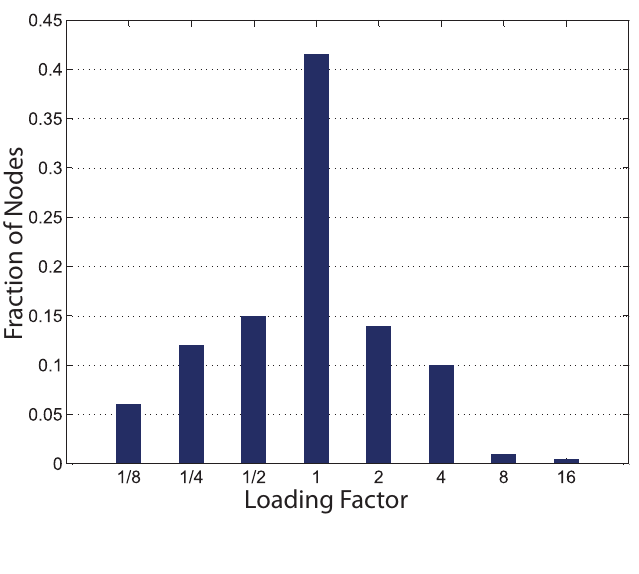
Figure 12. Distribution of the loading